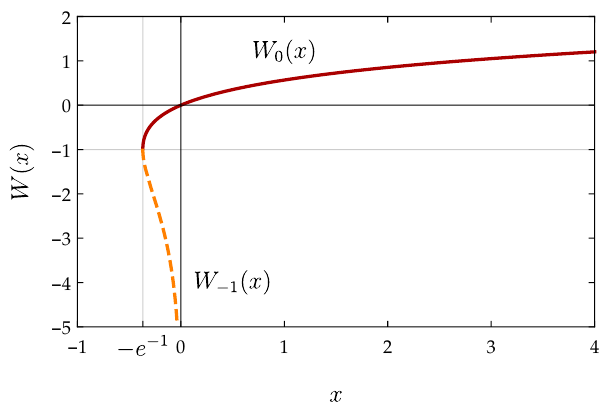
Figure 4 . The two real branches of the product logarithm